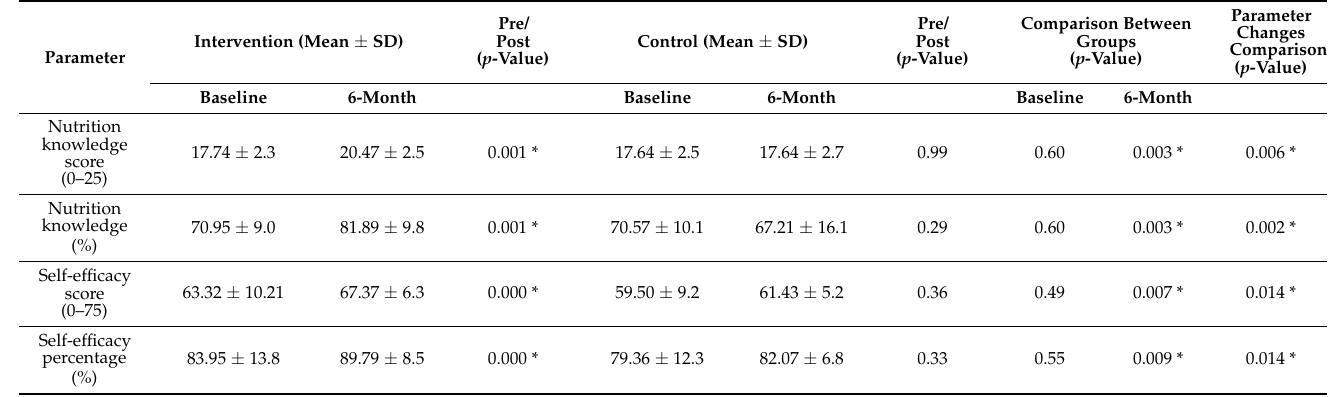
Table 4. Comparison of Nutrition Knowledge and Self-Efficacy at Baseline/6 Months and Changes in Intervention and Control Groups of People Living with HIV and Prediabetes Participating in a Nutrition Intervention to Improve Nutrition Knowledge and